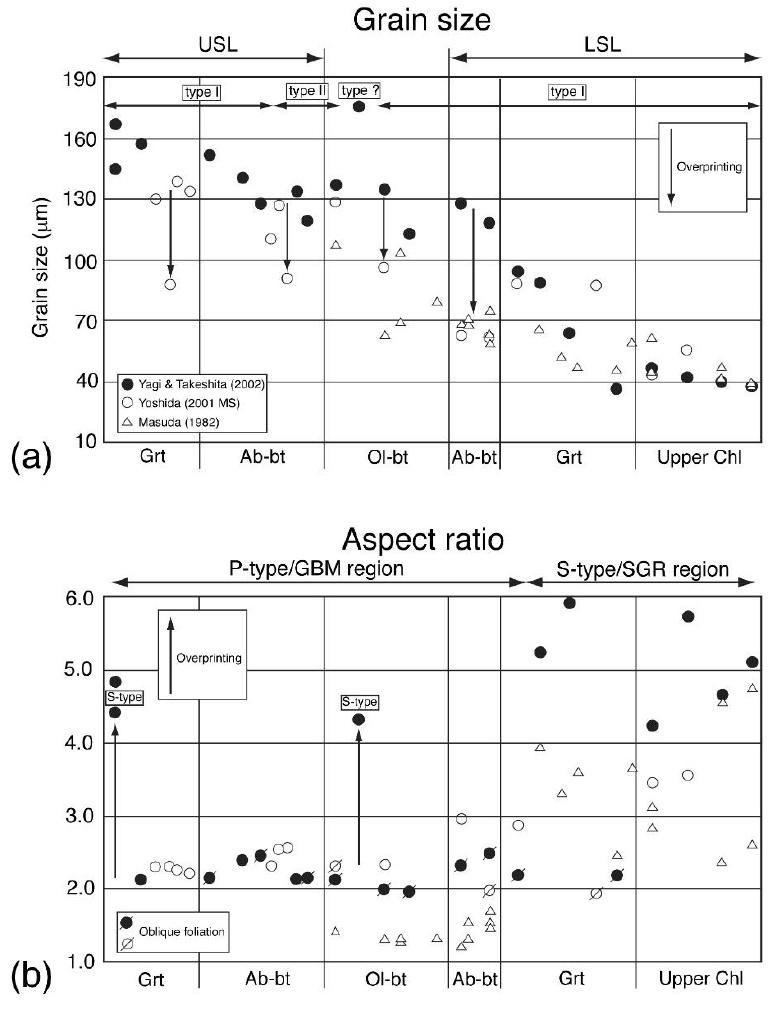
Figure 3. Plot of ( a ) the recrystallized grain size and ( b ) aspect ratio along the Asemi-Saruta-Dozan River traverse, which are projected on the traverse line (A-A’ shown in Figure 2). Since the layers uniformly strike WNW-ENE and dip north at 20 – 50°, the horizontal distance along the traverse line shown by the horizontal axis is roughly proportional to the thickness normal to the layers. Different symbols indicate grain size and shape data after different authors, which are shown in ( a ). See Figure 2 for the sample localities of [20,46,55]. Arrows indicate a large difference from the average value in ( a ) the recrystallized grain size and ( b ) aspect ratio, which can be interpreted as overprinting deformation (see text). “Type I” and “type II” with arrows at both ends ( a ) indicate the spatial distribution of type I and type II crossed girdle quartz c -axis fabrics, which develop in quartz schist samples. In ( b ), arrows at both ends indicate the spatial distribution of S-type and P-type recrystallized quartz grains after [20], which is inferred to be formed by subgrain rotation (SGR) and grain boundary migration (GBM) recrystallization, respectively (see text). See text for abbreviations of each of the peak-metamorphic zones.